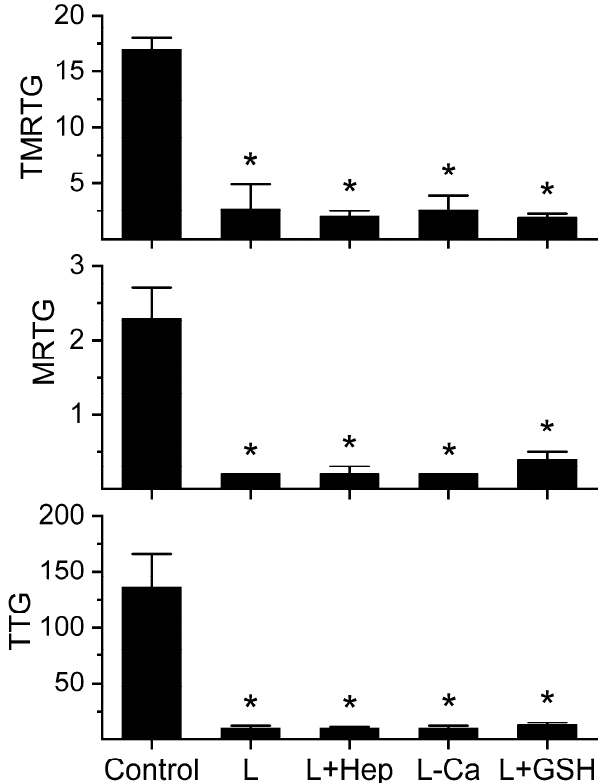
Figure 2. The kinetomic effects of LAAO on plasma containing heparin, no calcium, or GSH. The data are displayed as the mean ± SD. TMRTG = minutes; MRTG = dynes/cm 2 /sec; TTG = dynes/cm 2 . Control = plasma without the LAAO exposure; L = plasma with additive naive 500 nM LAAO; L + Hep = LAAO added to plasma with heparin 10 U/mL addition; L-Ca = LAAO added to plasma without calcium addition; L + GSH = LAAO added to plasma with 1 mM GSH addition. * p < 0.05 versus Control.